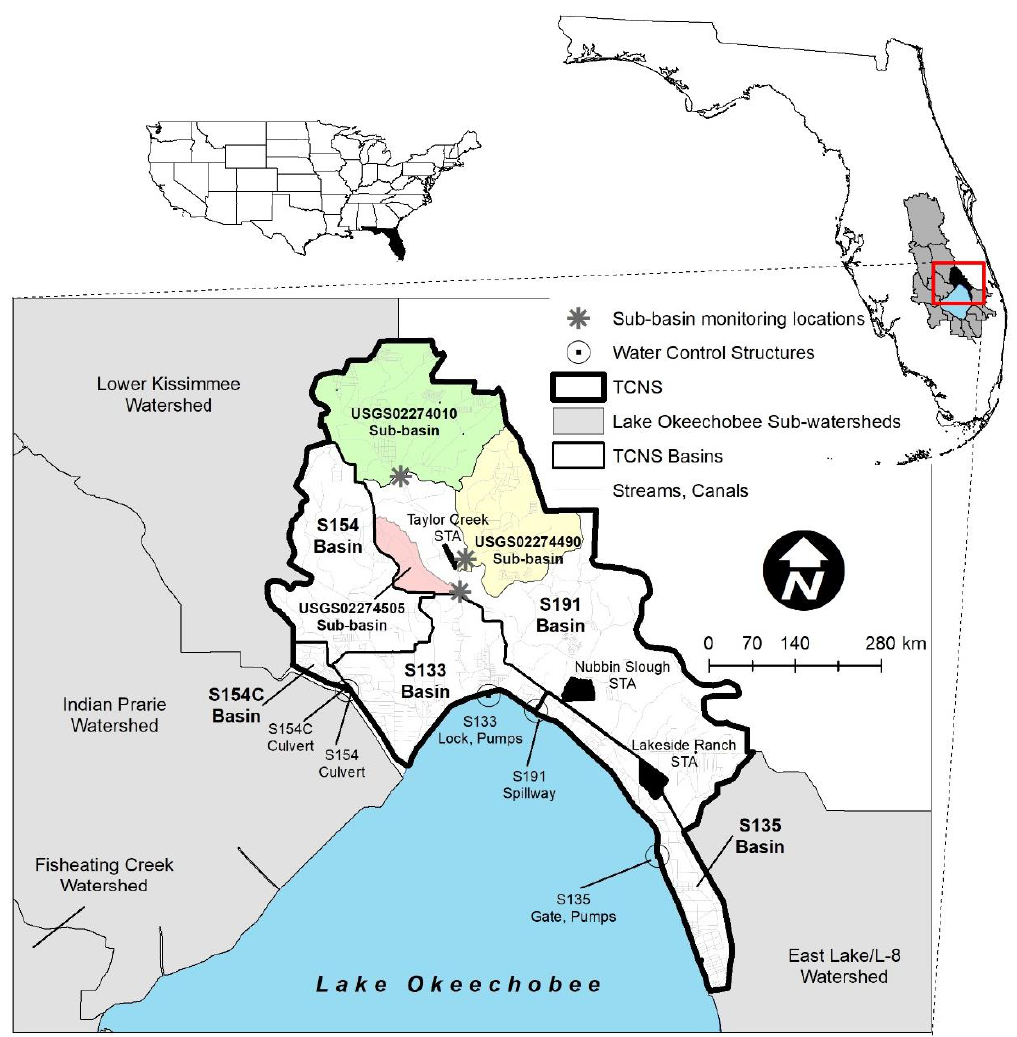
Figure 1. Location of the Lake Okeechobee Watershed (LOW) in the state of Florida, U.S.A. (grey-shaded area in the upper-right map), and the Taylor Creek Nubbin Slough (TCNS) sub-watershed (black-shaded area in the upper-right map and with each basin of the TCNS sub-watershed expanded in the lower map).